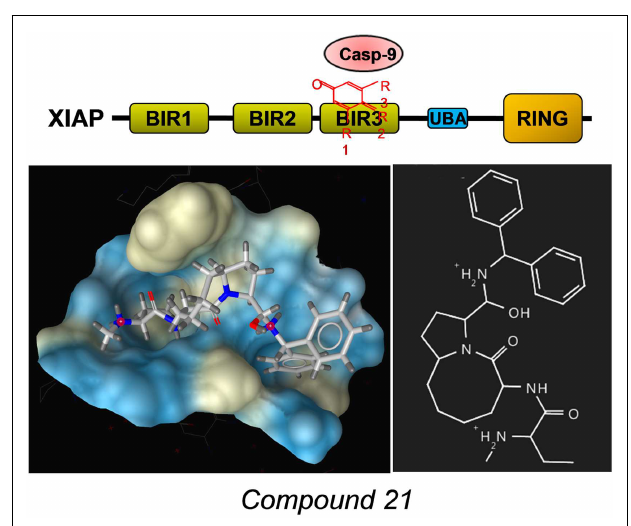
FIGURE 4 | Example for a SMAC-mimetic bound to the XIAP–BIR3 binding pocket . Compound 21, a chemical derivative structurally related to the AVPI peptide was crystallized in complex with a XIAP–BIR3 protein fragment [PDB number: 2JK7 (79)]. From the calculation of the binding pockets, the similarity in the mode of binding between this SMAC-mimetic and the AVPF peptide ( Figure 3 ) becomes evident.The surface of the binding pocket was calculated using LigandScout (Inte:ligand GmbH, Vienna). Color encoding shows hydrophobic areas in